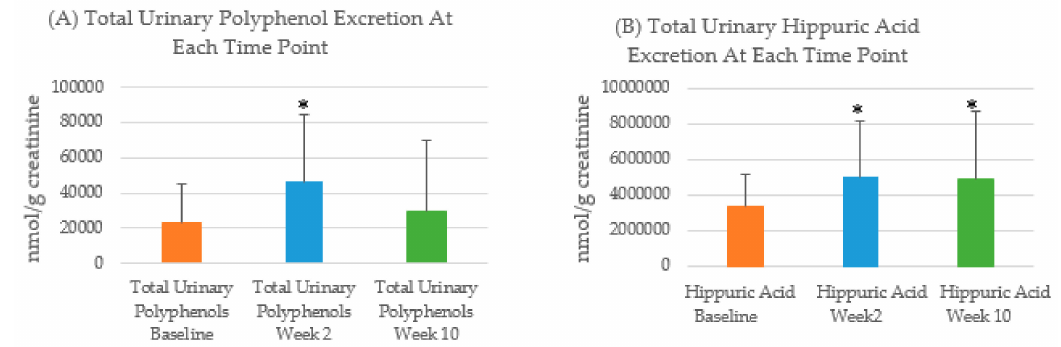
Figure 2. Urinary biomarker excretion at baseline, week 2 and week 10. ( A ) Average (SD) total urinary polyphenol (nmol / g creatinine) excretion at baseline, week 2 and week 10; * significant from baseline; ( B ) Average (SD) hippuric acid excretion (nmol / g creatinine) at baseline, week 2 and week 10; * significant from